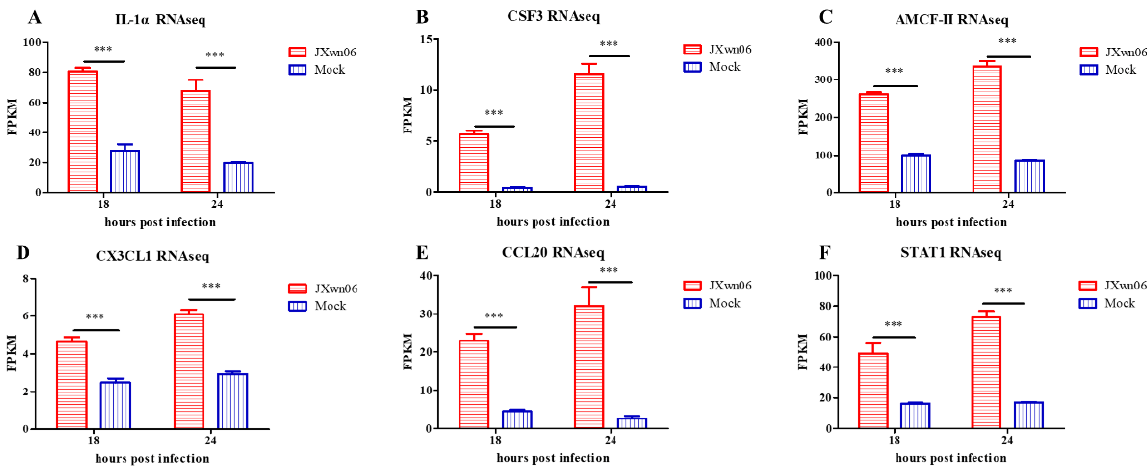
Figure 4. Analysis of several DEGs associated with cytokine–cytokine receptor interactions and chemokine signaling pathway. RNA-seq data in fragments per kilobase million (FPKM) for ( A ) IL-1 α , ( B ) CSF3, ( C ) AMCF-II, ( D ) CX3CL1, ( E ) CCL20, and ( F ) STAT1 for comparison are presented. The data are shown as means ± SD (standard deviation), n = 3 independent experiments. Asterisks indicate statistical significance (***, p < 0.001).